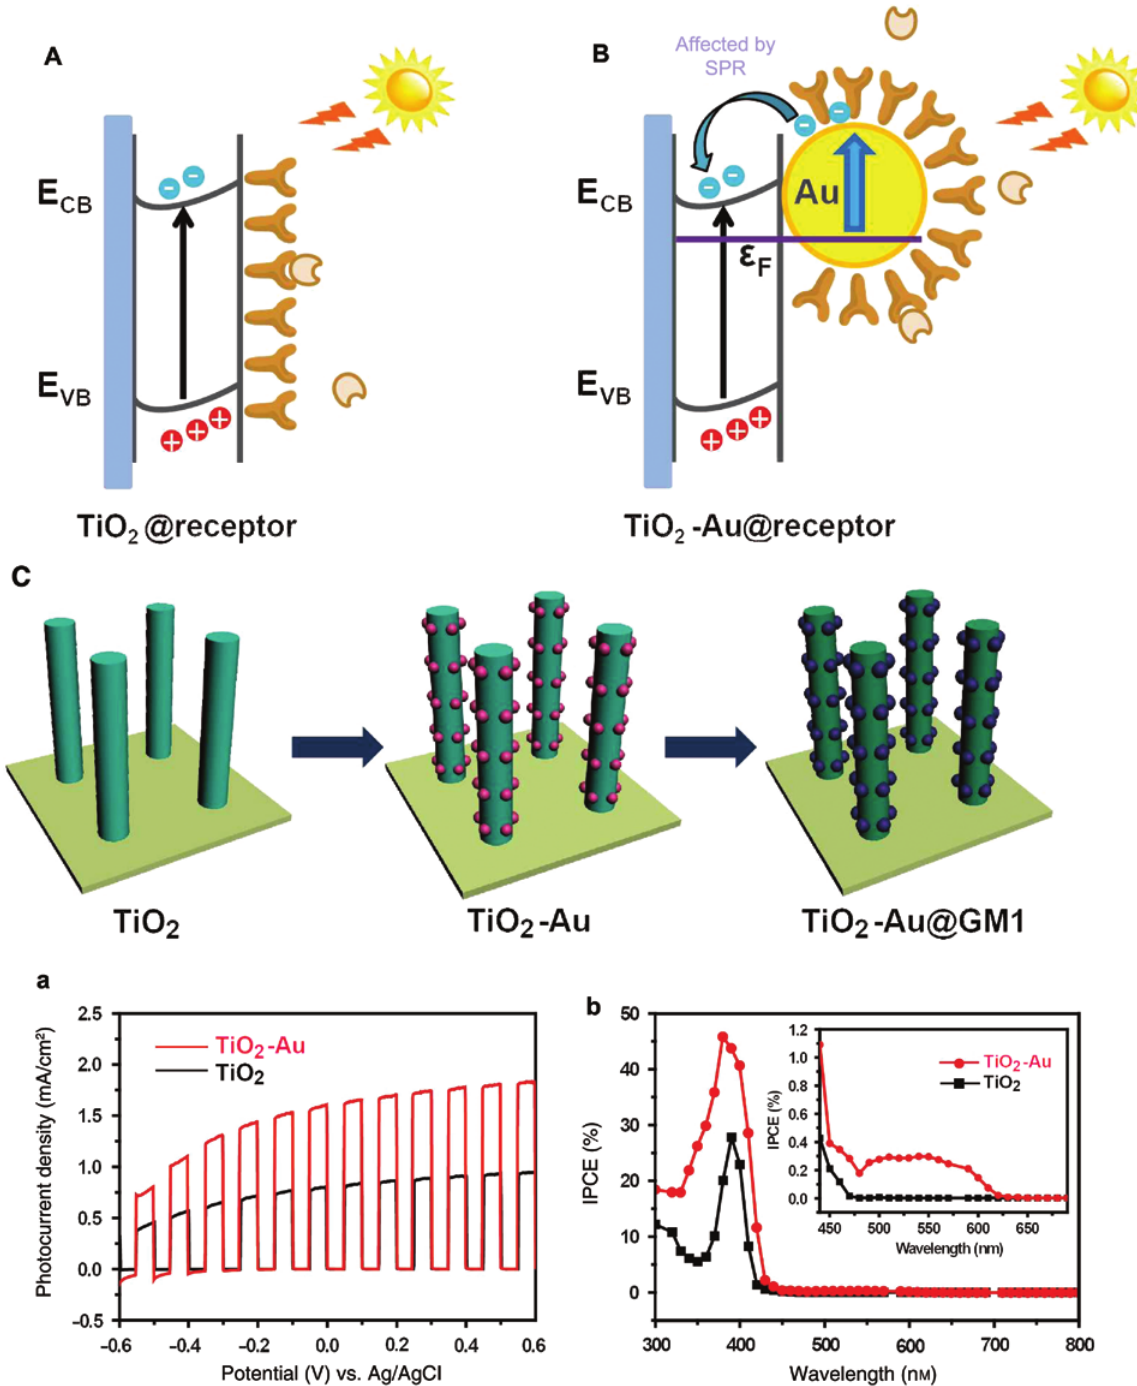
Figure 5: Schematic illustrating a comparison between PEC sensing in conventional and Au NP SPR-enhanced procedures: (A) surface recep- tor functionalization (GM1) as well as molecular target binding on TiO sensor surfaces. (B) Au NP decoration of a TiO PEC sensor, in which the 2 2 surface receptor functionalization (GM1) is applied on the surface of Au NP. The molecular target binding to the receptor leads to efficacious tuning of the energy coupling and charge transfer across the Au and TiO interface. (C) Preparation of TiO NW-decorated Au NPs and subse- 2 2 quent surface modification of Au surface with ganglioside GM1. Plots: (a) Comparison of photocurrent densities of Au NP-decorated TiO NWs 2 (red curve) and pristine TiO NWs (black curve) and TiO NWs decorated with Au NP (red curve), related to on/off cycles of simulated sunlight 2 2 illumination, which reveals higher photoactivity of TiO -Au NW. (b) The incident photon to converted electron (IPCE) spectrum obtained for 2 pristine TiO NWs and TiO NWs decorated with Au in wavelength range tuned between 300 and 800 nm at 0.23 V against Ag/AgCl. As can be 2 2 seen, there was a lower maximum value of ~ 28% at 390 for pristine in comparison with TiO NWs decorated with Au. Reprinted with permis- 2 sion from Ref. [183]; copyright 2014, American Chemical